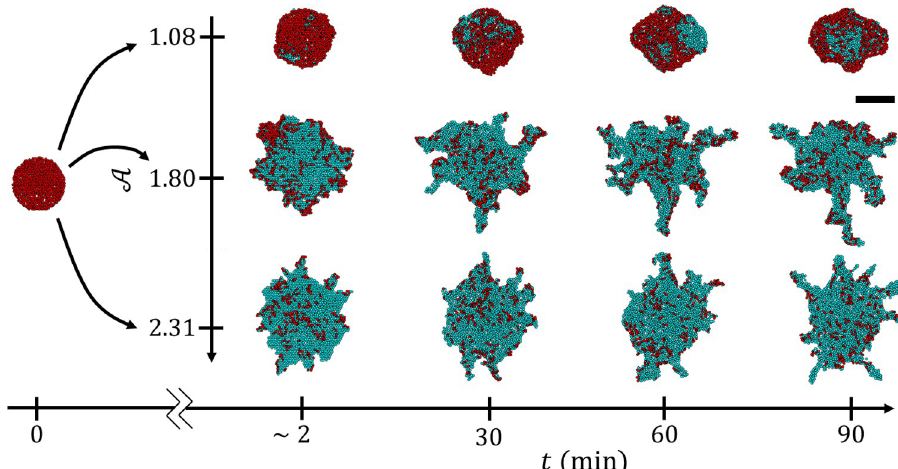
Fig 5. Dynamic Effects of Activity Level. Snapshots of modelled rafts at different simulation times ( t ) and activity levels ( A ) are depicted to illustrate the effect of A on raft development. The raft on the far left depicts the initial conditions which were the same for each simulation throughout this work (a circular raft with ϕ = 1). On the right each row depicts a single raft as it evolves in time (moving from left to right along the horizontal axis). For all simulations shown, η = 0.2 and R = 0.9 ℓ . Structural agents are depicted in cyan, while dispersed free agents are depicted in red. The scale bar in the top right is universal to all snapshots and represents 14 ℓ .